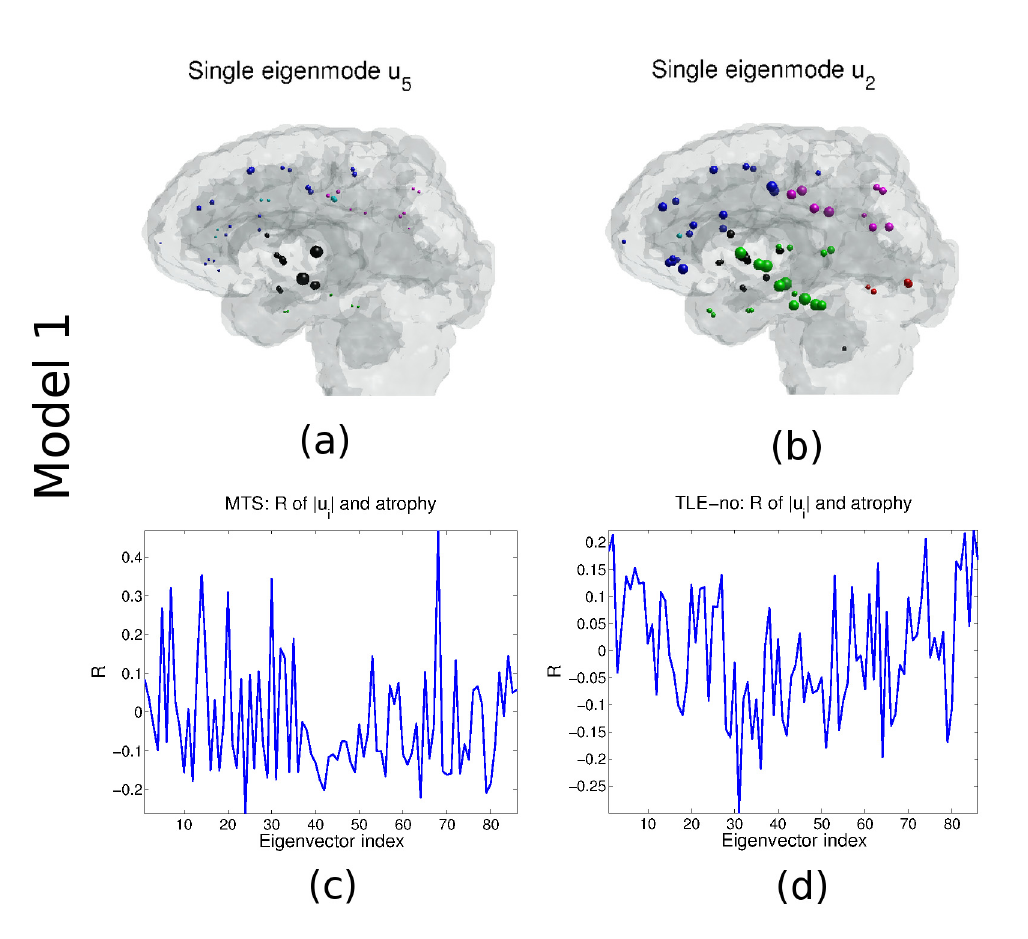
Fig 2. Model 1: Atrophy distribution via exitotoxicity. (a) Eigen-mode u 5 captures the essentials of estimating network diffusion from the Laplacian ’ s eigen-modes for TLE-MTS when the ipsilateral hippocampus is seeded. (b) Eigen-mode u 2 recovers features of the TLE-no when the temporal lobe is bilaterally seeded. (c) Plot of R vs the eigen-mode index for TLE-MTS when each eigen-mode u i is correlated with the group atrophy. (d) Plot of R vs. the eigen-mode index for the TLE-no when eigen-modes u i are each correlated with the group atrophy.